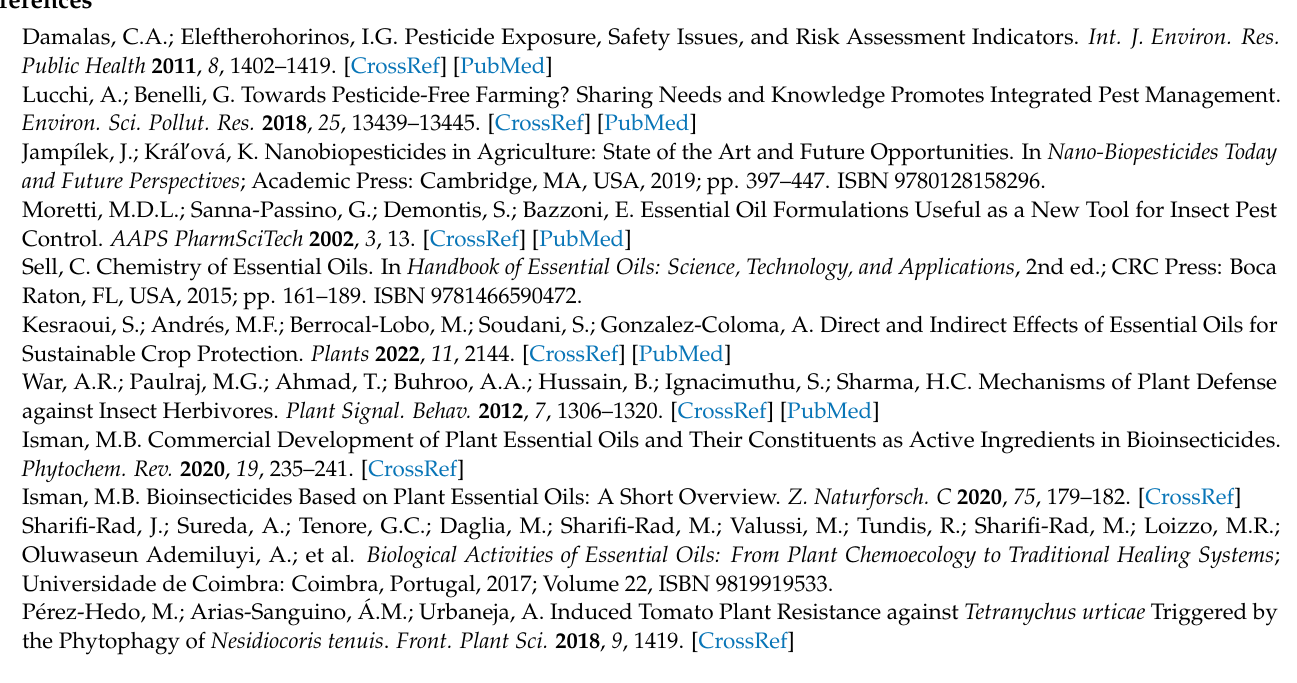
Table S2: Essential oil composition of Achillea millefolium identified by GC-MS; Table S3: Essential oil composition of Allium sativum identified by GC-MS, Table S4: Essential oil composition of Rosmarinus officinallis identified by GC-MS, Table S5: Essential oil composition of Rosmarinus officinallis identified by GC-MS, Table S6: Essential oil composition of Thymus zygis identified by